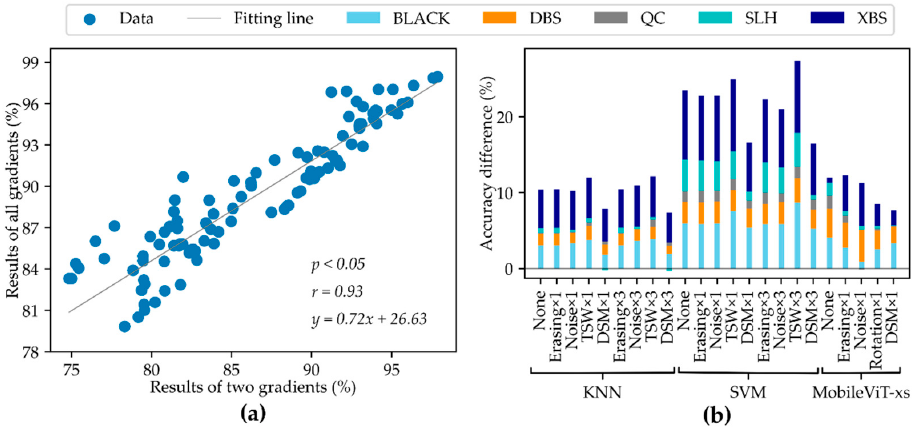
Figure 6. Comparison of different gradient results. ( a ) correlation of two gradient results and all gradient results, ( b ) difference between two gradient results and all gradient results. The results of two gradients indicate the results of G1 and G2. The results of all gradients indicate the results of G1, G2, and G3. BLACK, Black peanut; DBS, Dabaisha; QC, Qicai; SLH, Silihong; XBS, Xiaobaisha; None, original data; Erasing, random erasing; Noise, random noise; TSW, two sample weighting; DSM, difference of spectral mean; Rotation, rotation; KNN, K-nearest neighbors, SVM, support vector machines.